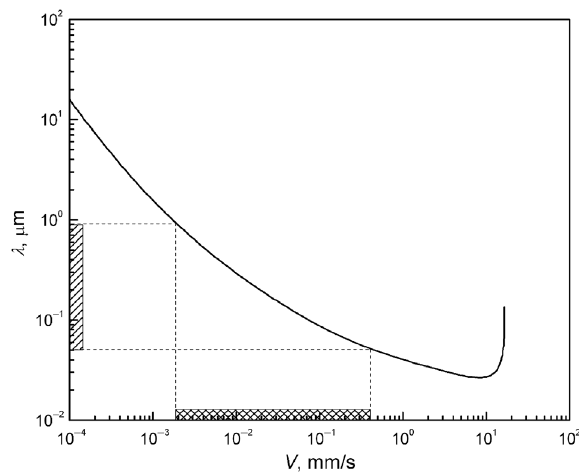
Figure 3: Calculated solidification rate V versus eutectic spacing λ in Fe-10%Nb.